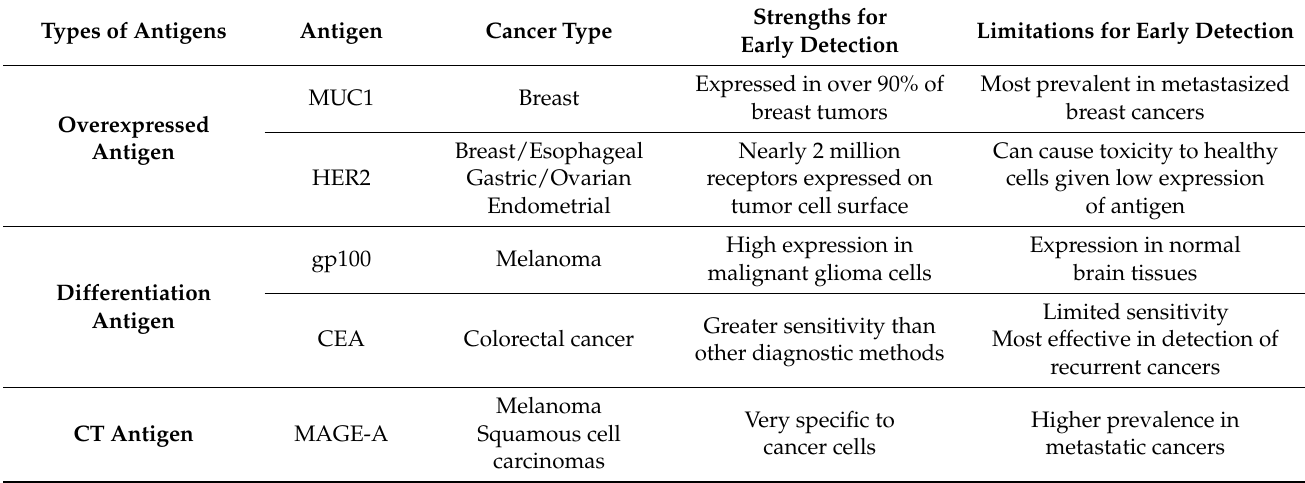
Table 1. Candidates for Early Detection Biomarkers to Cancer Phenotype: Advantages and